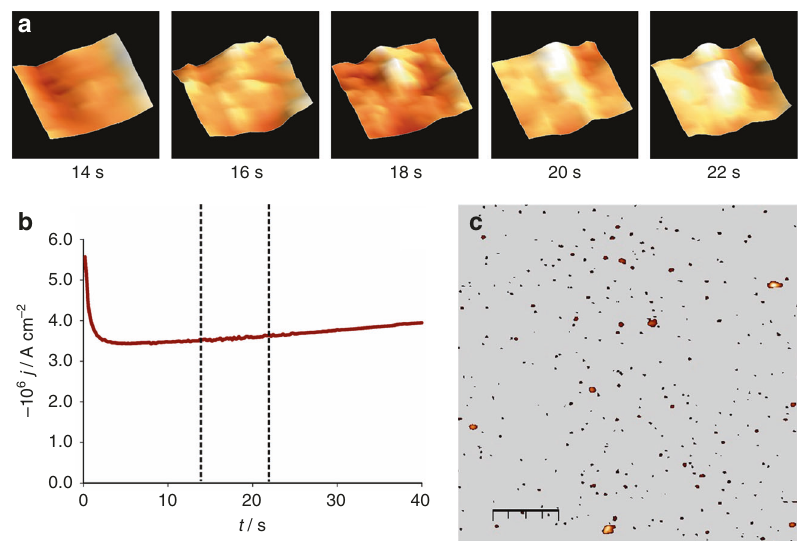
Fig. 3 Birth and growth of a copper nucleus. a 46 × 46 nm 2 cropped regions from 85 × 85 nm 2 in-situ HS-LMFM scans, taken from 14 to 22 s after the potential step ( dashed lines on b ), highlighting the birth and growth of a copper nucleus. b The chronoamperometric transient recorded at − 0.27 V in